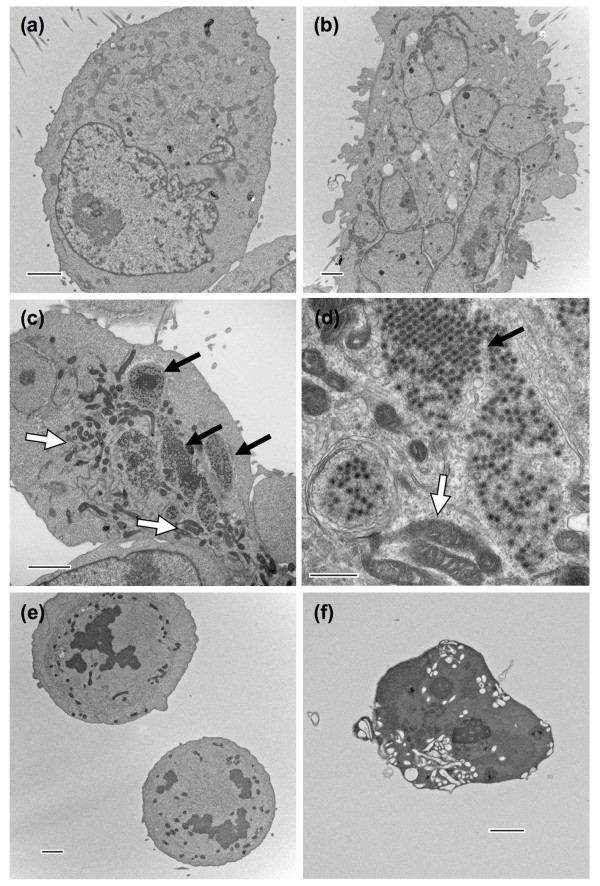
Transmission electron micrographs of NCI-H23 cells treated with either paclitaxel (1 μM) or ReoT3D (MOI = 20) alone, or both in combination for 20 hours. Compared to untreated control (a), the increased number of paclitaxel-treated NCI-H23 cells were found to be enlarged and multinucleated (b), whereas the cells infected with ReoT3D (c and d) contained numerous viral particles, mostly in viral inclusion bodies, which appeared globular in shape (black arrows). In addition, ReoT3D-infected cells appeared to contain an increased number of mitochondria (white arrows). When the cells were exposed to the combination of ReoT3D and paclitaxel, there were increased numbers of mitotic cells (e) as well as apoptotic cells characterized by condensed chromatin, cytoplasmic shrinkage and vacuolation (f). The results from survey of 100 cells for each treatment group are summarized in Table 3. Scale bars: 2 μm for (a), (b), (c), (e) and (f), and 500 nm for (d).